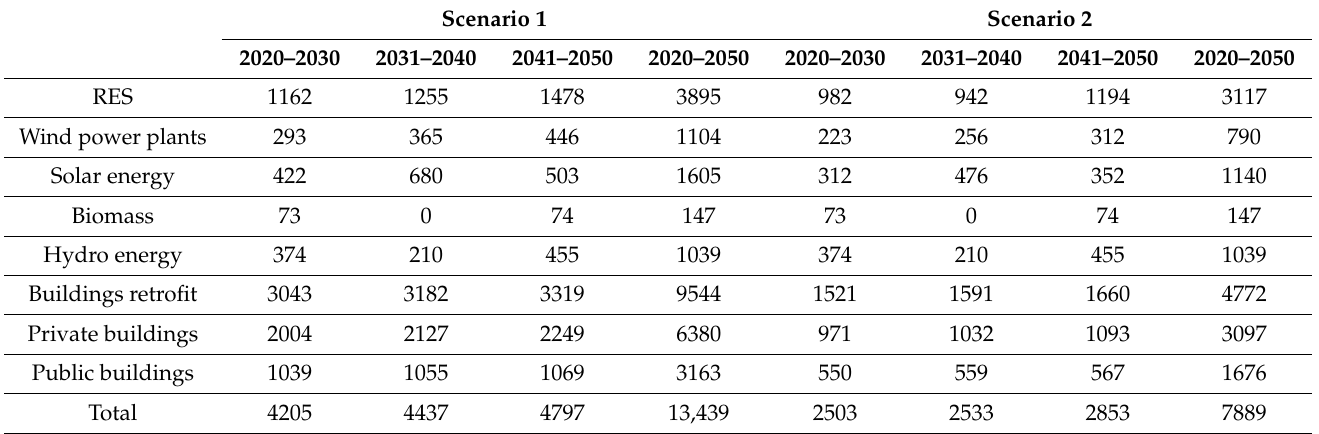
Table 4. GVA effects of energy transition in Croatia, in million